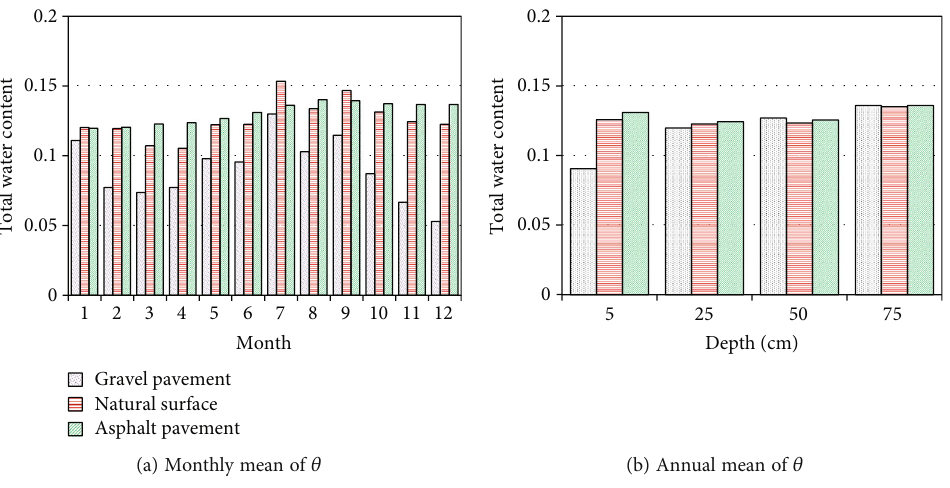
Figure 6: Soil water content under di ff erent underlying